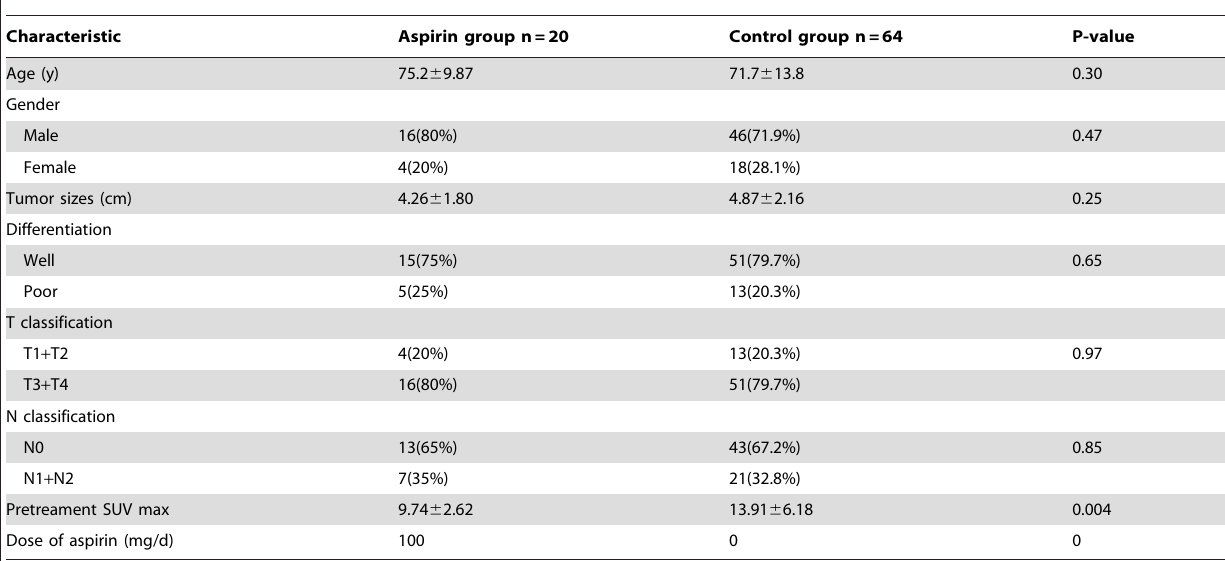
Table 1. Patient demographics and clinical characteristics.